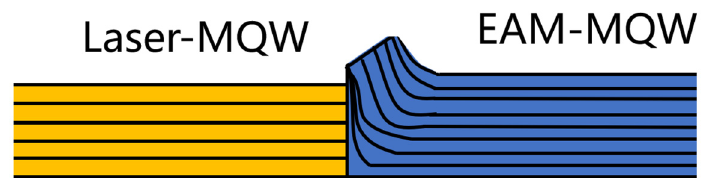
Figure 19. Schematic of the EAM and laser MQWs achieved using the butt-joint technique.